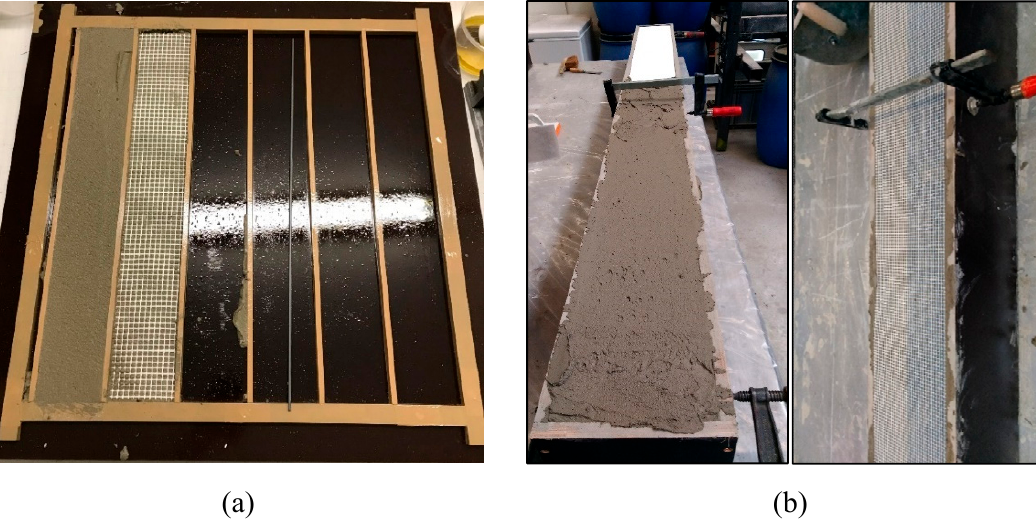
Figure 4. A hand lay-up technique was used for the preparation of the specimens: ( a ) TRC coupons and ( b ) sandwich beams with TRC faces.